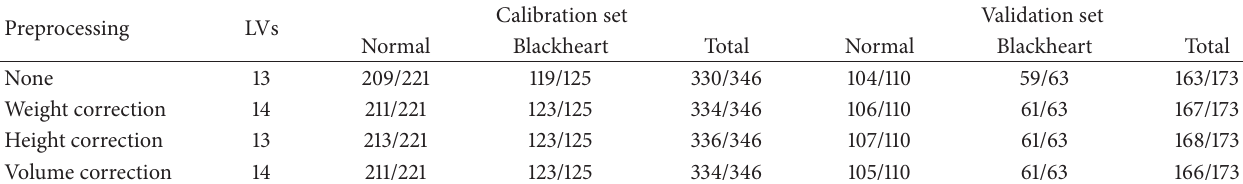
Table 2: Classification results based on PLS-LDA with different preprocessing methods and full